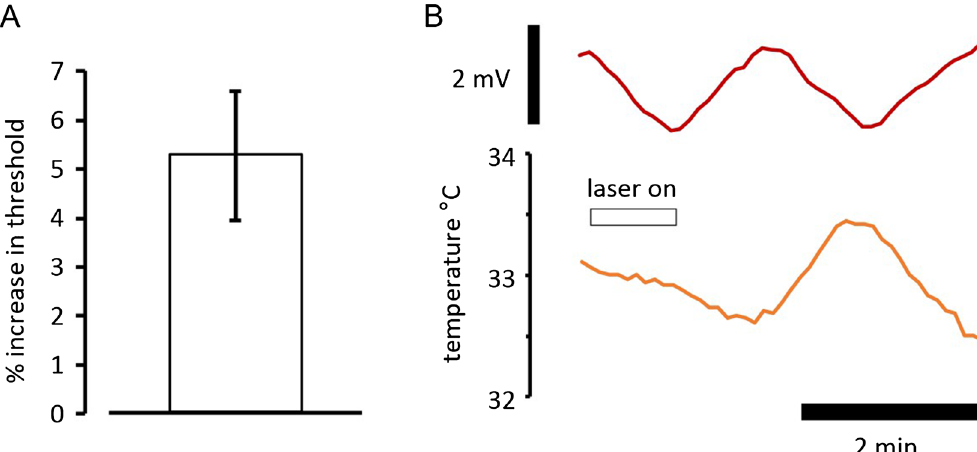
Figure 3. IR laser light application at the site of stimulation increases threshold; at the site of recording, the membrane potential hyperpolarizes. ( A ) With a driving current of 400 mA (equivalent to 600 mJ per minute), and continuous operation of the laser, a threshold increase is sustained for at least 3 min ( P = 0.017, n = 5). ( B ) Extracellular membrane potential recording (upper panel) reveals relatively slow changes in potential on the application of laser light (in this case 350 mA driving current) that mimic membrane potential changes caused by ambient temperature fluctuations in the bath (lower panel). As these potentials are recorded extracellularly they must be smaller than the membrane potential changes found intra-axonally, the latter likely to be of the order of a few single mV. The sustained increase in threshold therefore appears to be caused by a temperature dependent membrane